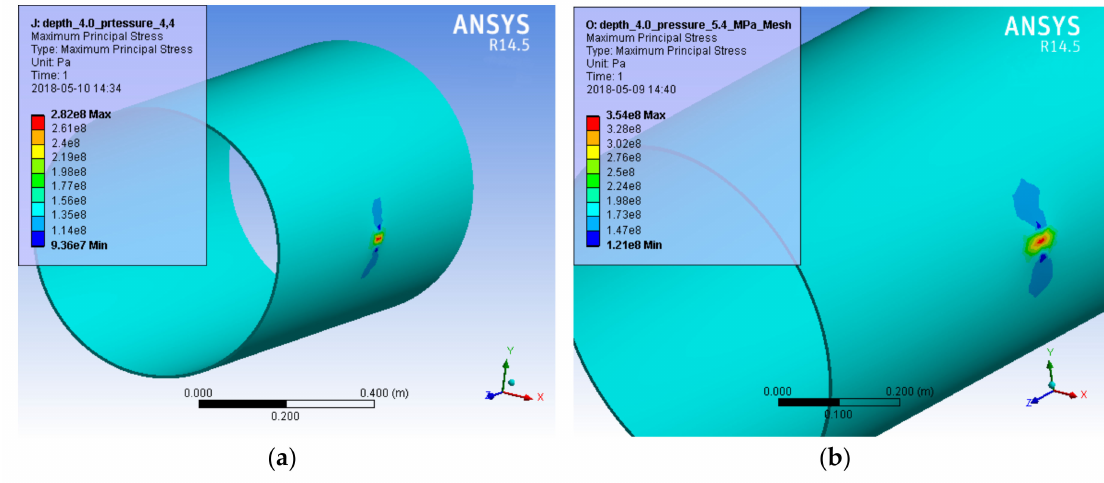
Figure 9. Maximal stresses in the pipe with a 4-mm deep gouge: ( a ) at a pressure of 4.4 MPa; ( b ) at a pressure of 5.4 MPa.